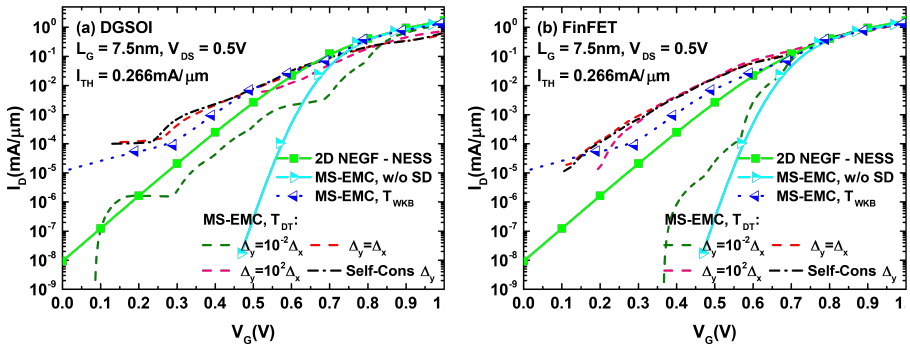
Figure 6. I D − V G characteristics for the DGSOI ( a ) and FinFET ( b ) with L G = 7.5 nm employing different methods for computing S/D tunneling. On one hand, we display the set of curves obtained from the MS-EMC tool using T WKB and T DT (with various ∆ y choices) and, on the other, the curve calculated using the NEGF formalism of